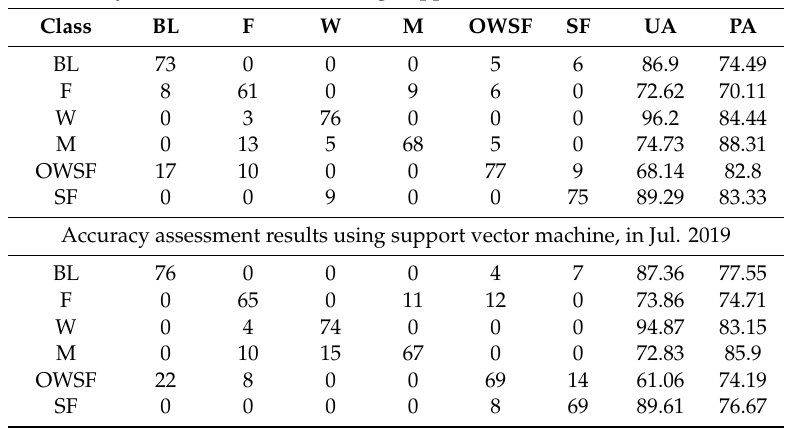
Table 7. The error matrix of classification results. Note: BL, bared land, F, forest, W, water bodies, M, marsh, OWSF, open wood savanna–flood, SF, salt flat, PA and UA are the producer’s and user’s accuracies,